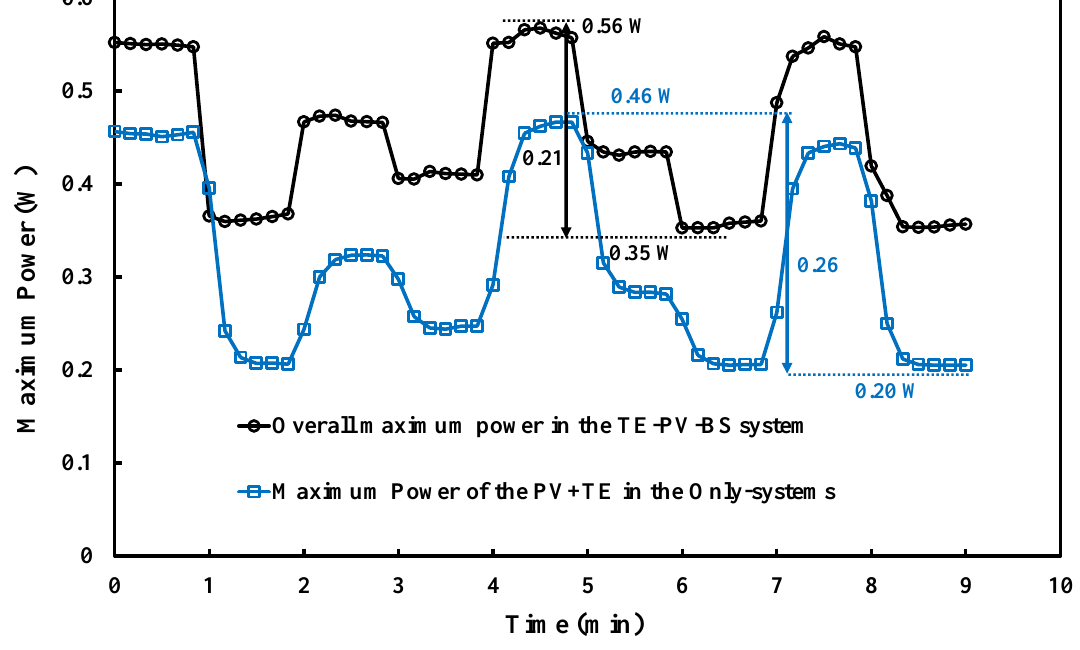
Figure 7. Overall maximum power generated by the hybrid system and the aggregation of the maximum powers in the PV- and TE-only systems. by the PV cell and TE module in each